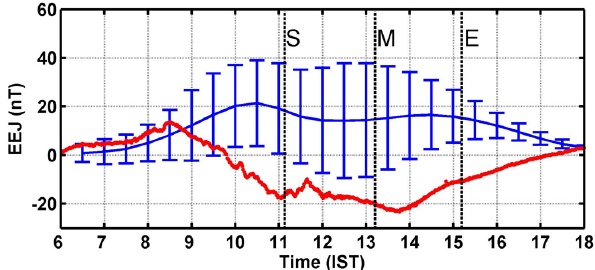
Fig. 6. Temporal variations of electrojet strength for the eclipse and control days during 06:00–18:00IST. The blue lines with error bar represent the mean values for the control days averaged for 30min. Red stars correspond to the observations of eclipse